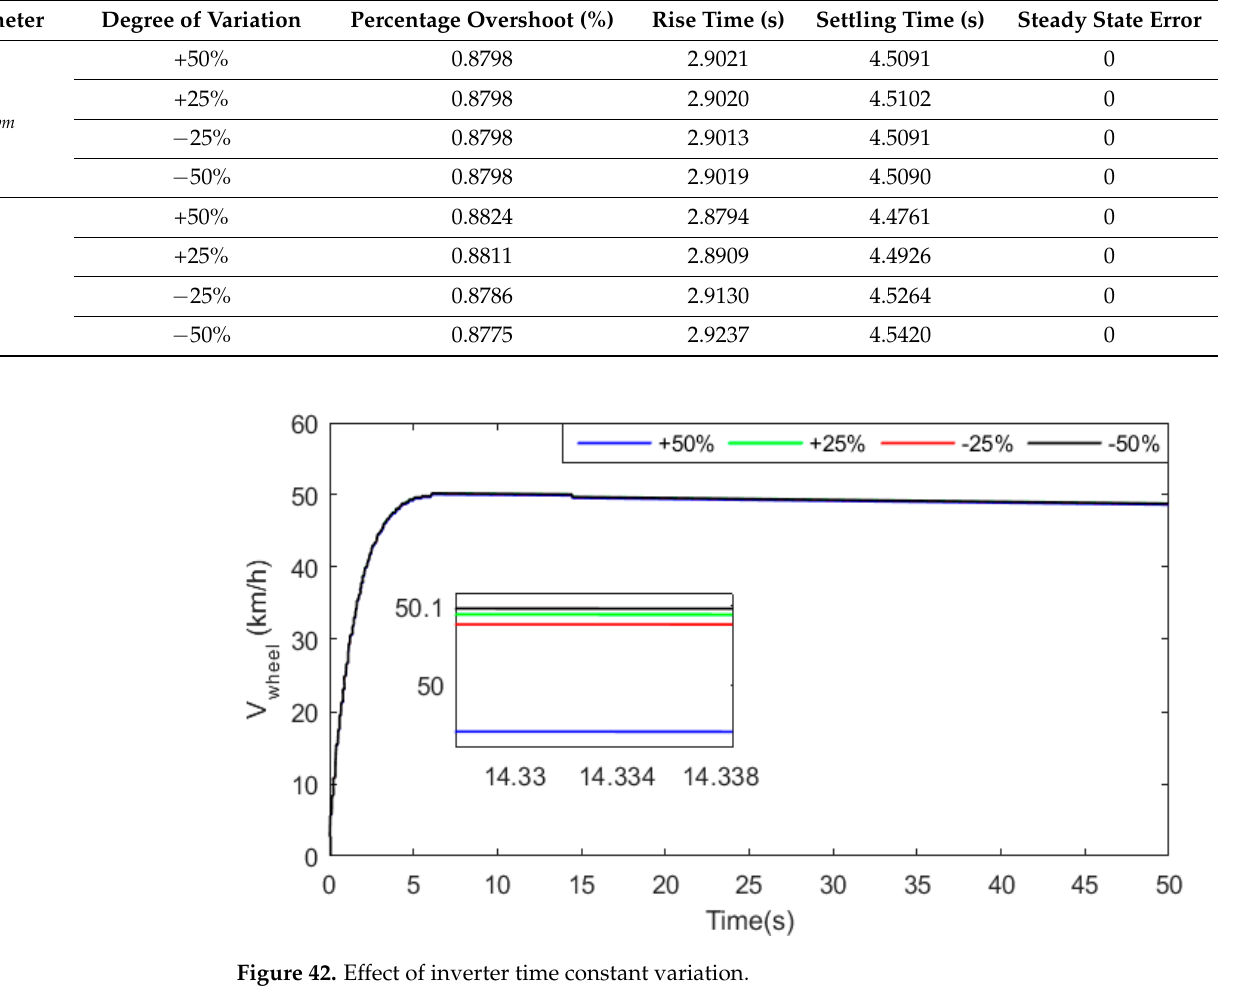
Table 7. Results of robustness analysis against BEV parameter variation.